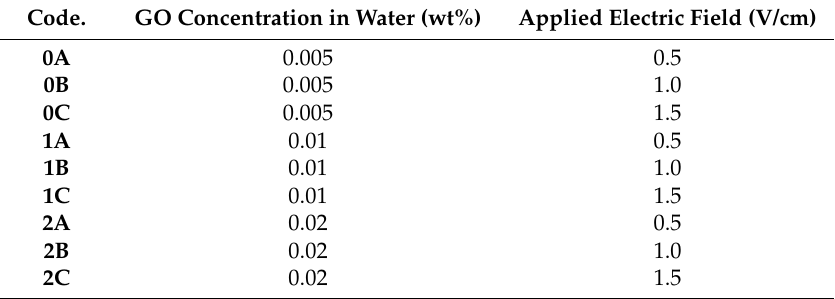
Table 1. Conditions of electrophoretic deposition of graphene oxide (GO) on glass fibers. Code. GO Concentration in Water (wt%) Applied Electric Field (V/cm)